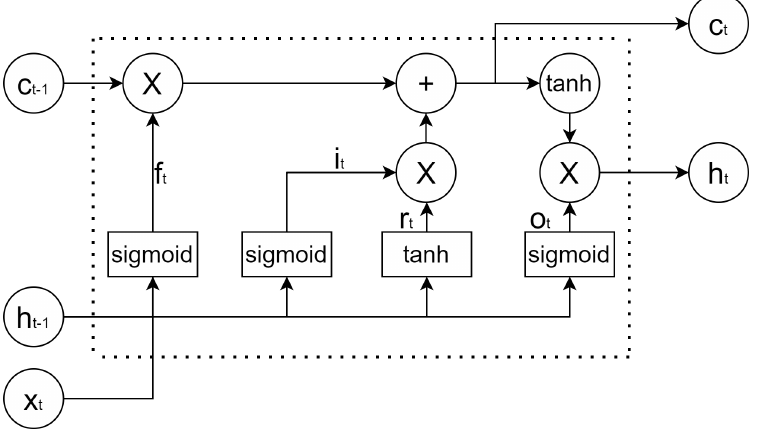
Figure 4. An LSTM unit